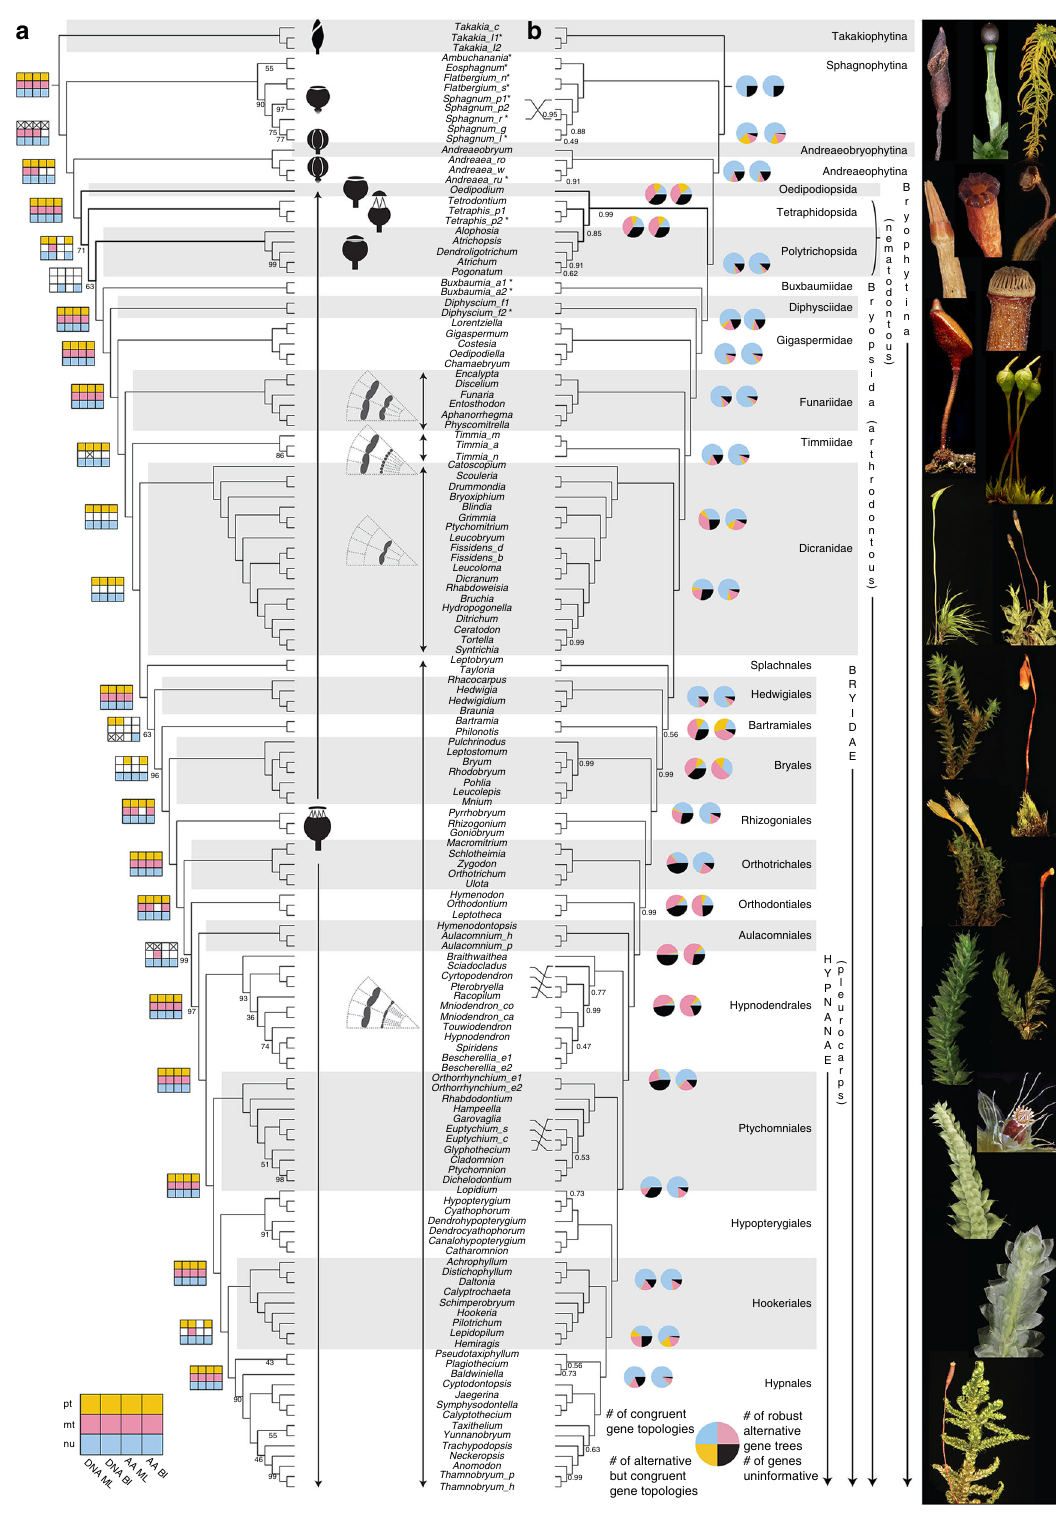
Results and Discussion Deep splits using targeted sequences from all compartments . thousands of protein-coding sequences has led to a re-evaluation, across the diversity of life. For example,